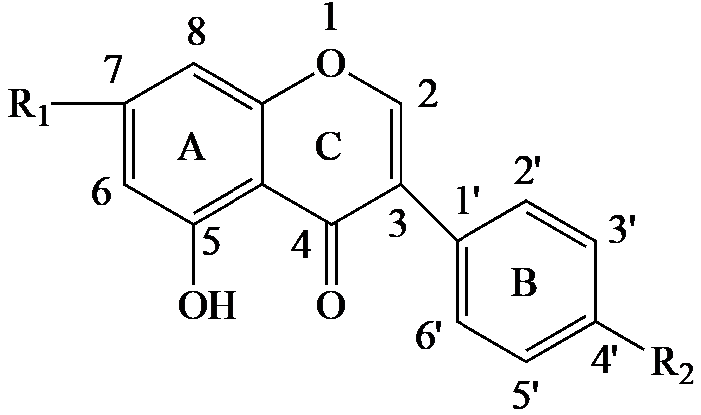
Figure 1. Chemical structure of BCA (R 1 = OH, R 2 = OCH 3 ) and purnetin (R 1 = OCH 3 , R 2 = OH).